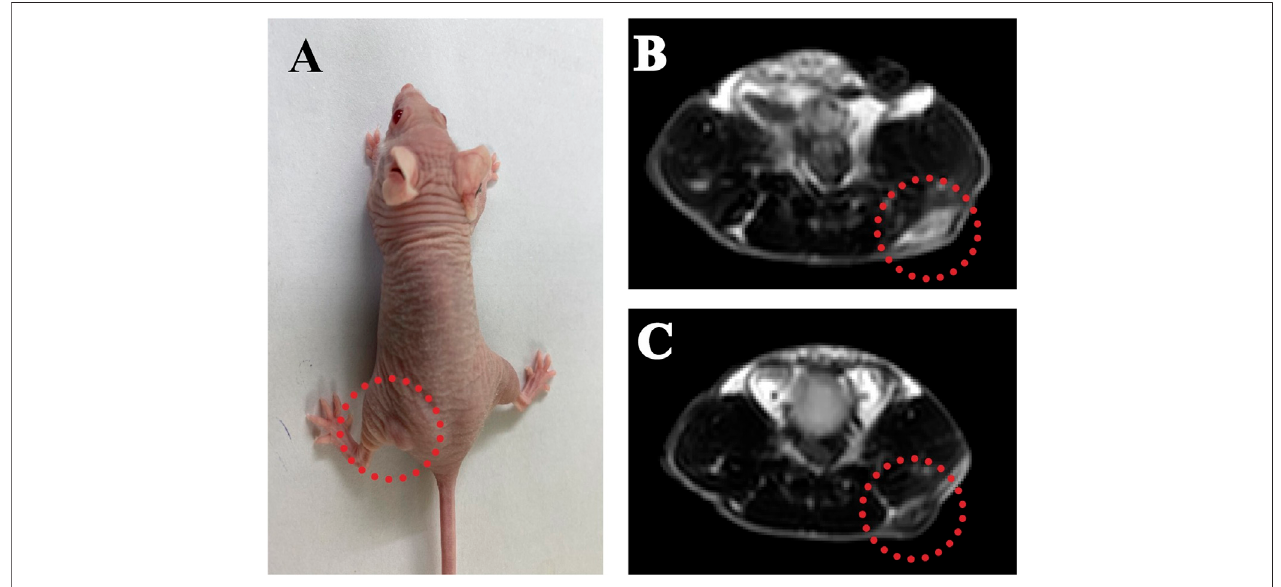
FIGURE 7 | The PPy@Fe 3 O 4 NPs can serve as MRI contrast agents to detect tumors. (A) Representative MRI images of A549 tumor-bearing mice; (B) T2- weighted MRI before and (C) after injection of PPy@Fe 3 O 4 dispersions.